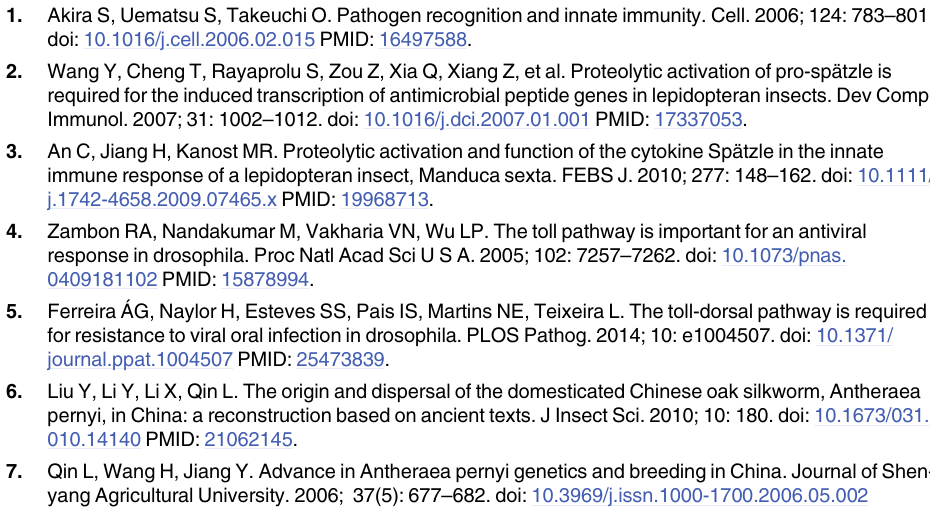
S1 Fig. Different developmental stages of A . pernyi . (TIF) S2 Fig. Survival conditions of A . pernyi larvae. (TIF) S1 Table. Sequences of primers used in this paper. S2 Table. Information on spatzles from different insect species used in Fig